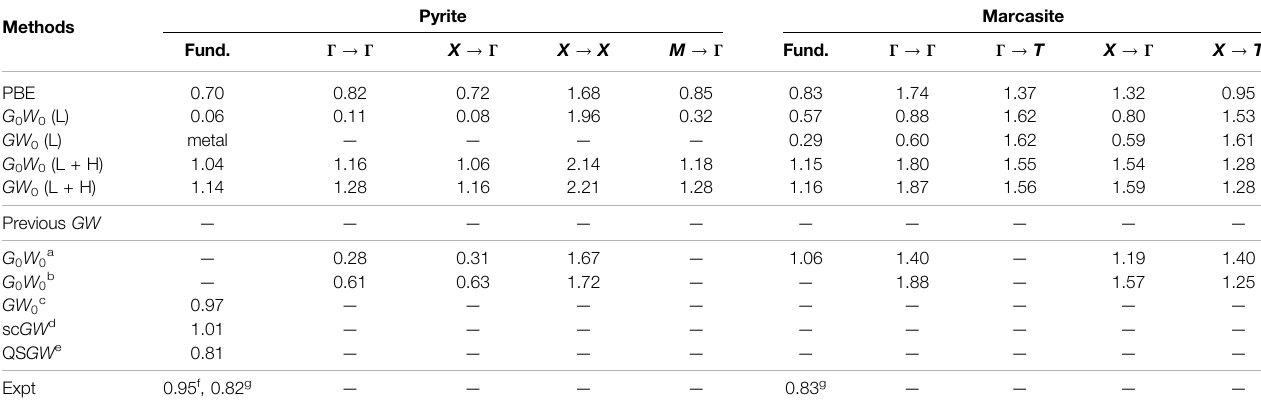
TABLE2| Fundamentalbandgap(indicatedby “ fund. ” )andotherdirectandindirectbandgaps(unit:eV)forpyriteandmarcasiteFeS 2 calculatedbyPBEand GW methods. Results from previous GW studies and experimental measurements are presented for comparison. To simplify the notation, we use “ L ” and “ L + H ” to denote the standard LAPW and LAPW + HLOs basis sets, respectively. PBE is used as the starting point for G 0 W 0 and GW 0 calculations unless stated otherwise.